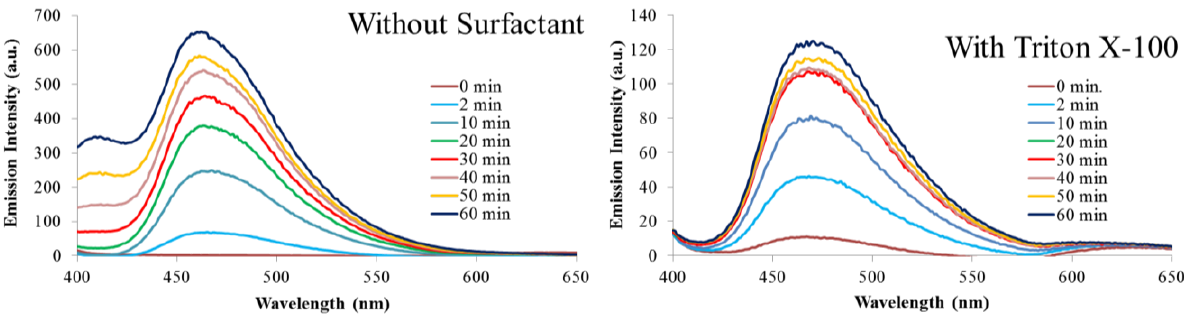
Figure 5 . Fluorescence emission (λ ex = 350 nm) as a function of reaction time.